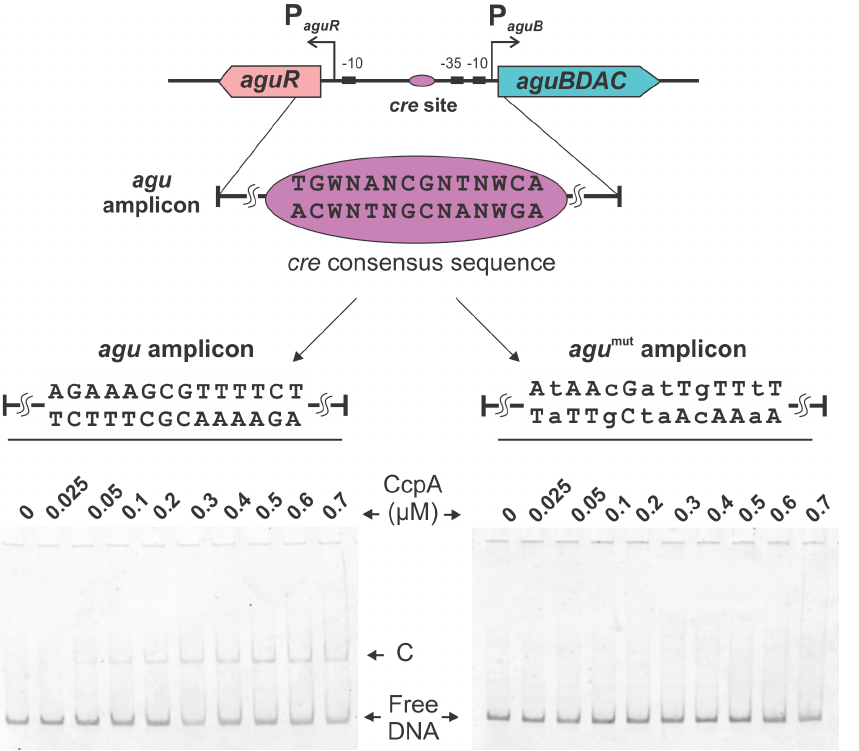
Figure 5. CcpA interaction with the aguR-aguBDAC intergenic region. For band shift assays, agu or agu mut amplicons (2.69 nM each) were incubated with increasing concentrations of CcpA (0.025–0.7 mM), 5 mM of P-Ser-HPr and 20 mM FBP. The arrow indicates position of the retarded complex (C). Consensus, wild type and mutated sequence of cre sites are indicated.